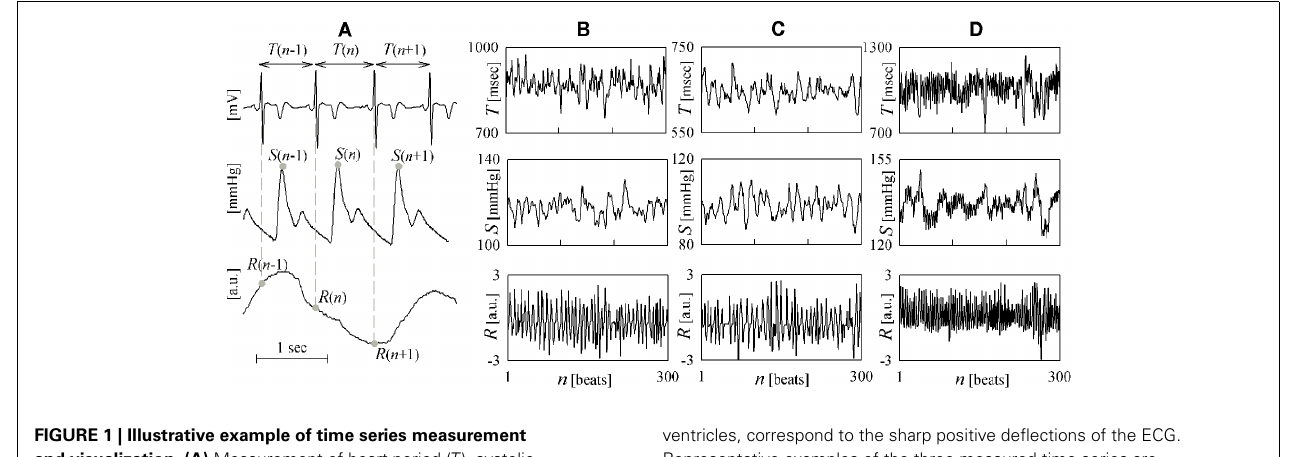
FIGURE 1 | Illustrative example of time series measurement and visualization. (A) Measurement of heart period ( T ), systolic arterial pressure ( S ) and respiration ( R ) variability series from the ECG, arterial blood pressure, and respiratory flow signals; consecutive R waves, representing early depolarization of the